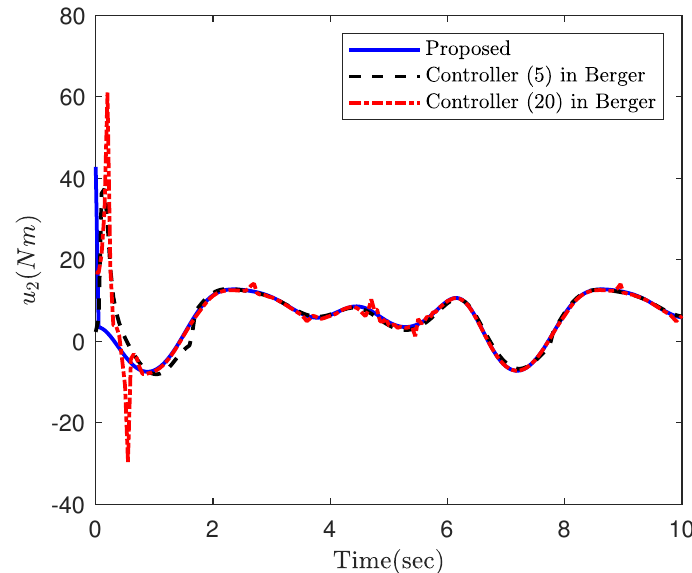
Figure 10. The second component of the control input in Part